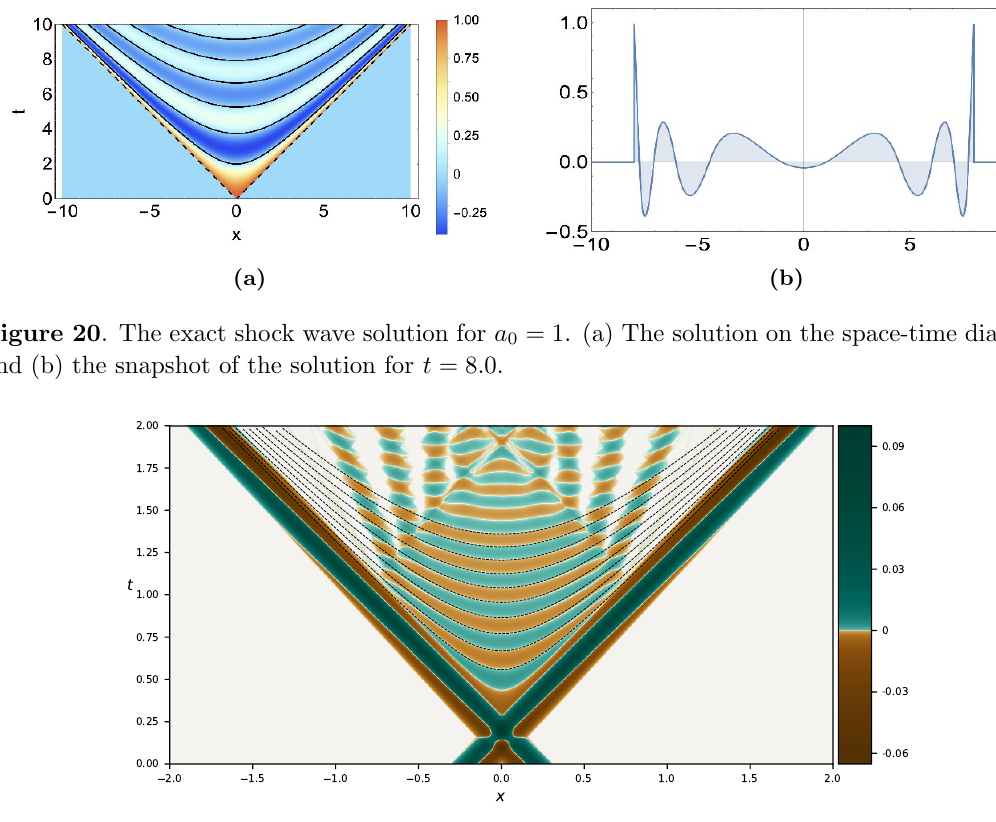
Figure 21 . Scattering of two exact oscillons for symmetric (cid:12)eld con(cid:12)guration. The incident oscillons move with the speed V = 0 : 95 in the laboratory reference frame. The diamond-shaped structure in the middle resembles the shock wave solution. The (cid:12)t of ten (cid:12)rst zeros was obtained for a 0 = 0 : 00541 and T 0 = 0 :